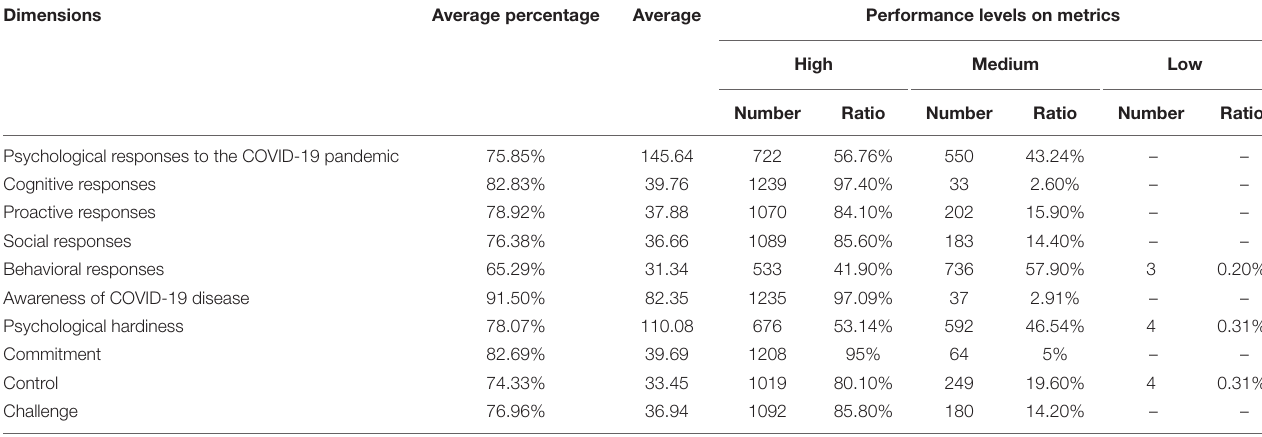
TABLE 1 | Average grade of the sample search on the measure of psychological responses to the COVID-19 pandemic and the average percentage ( n = 1272). Dimensions